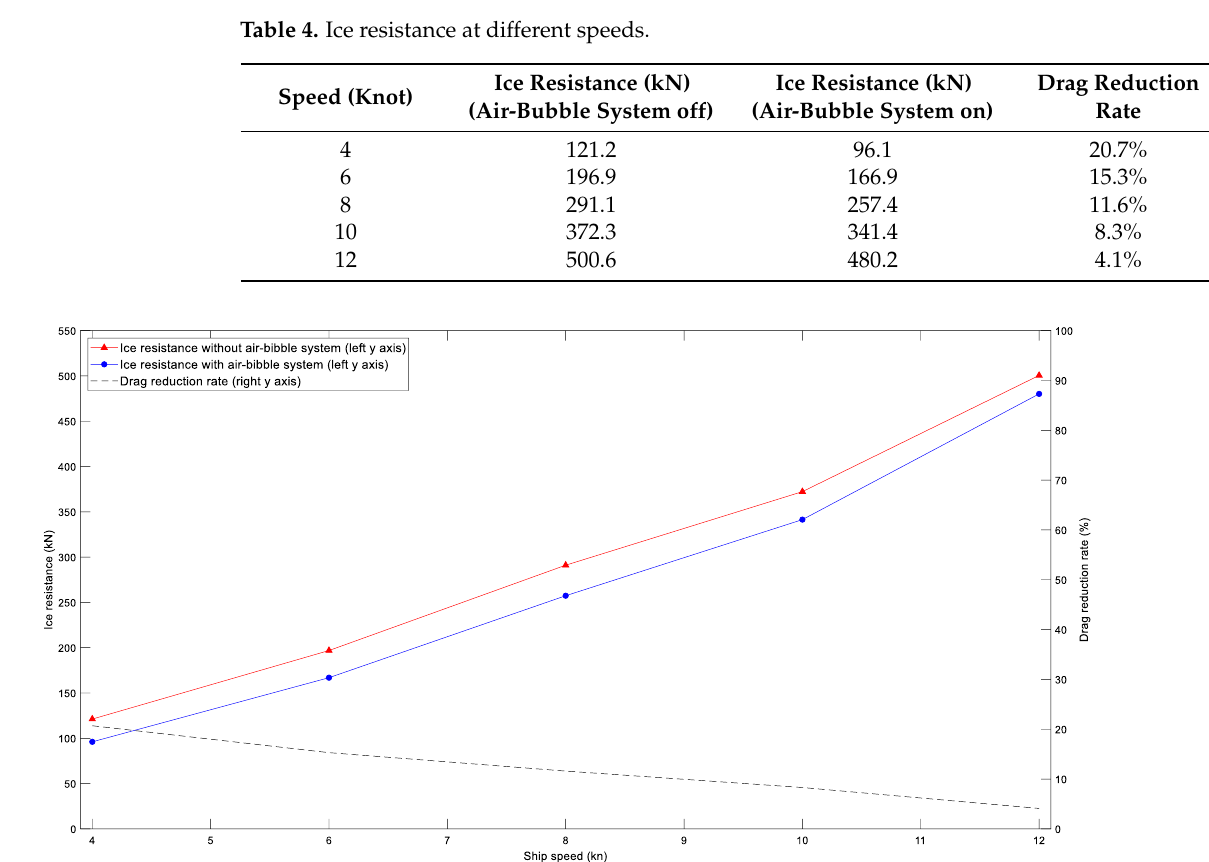
Figure 11. The ice resistance and drag reduction rate at different